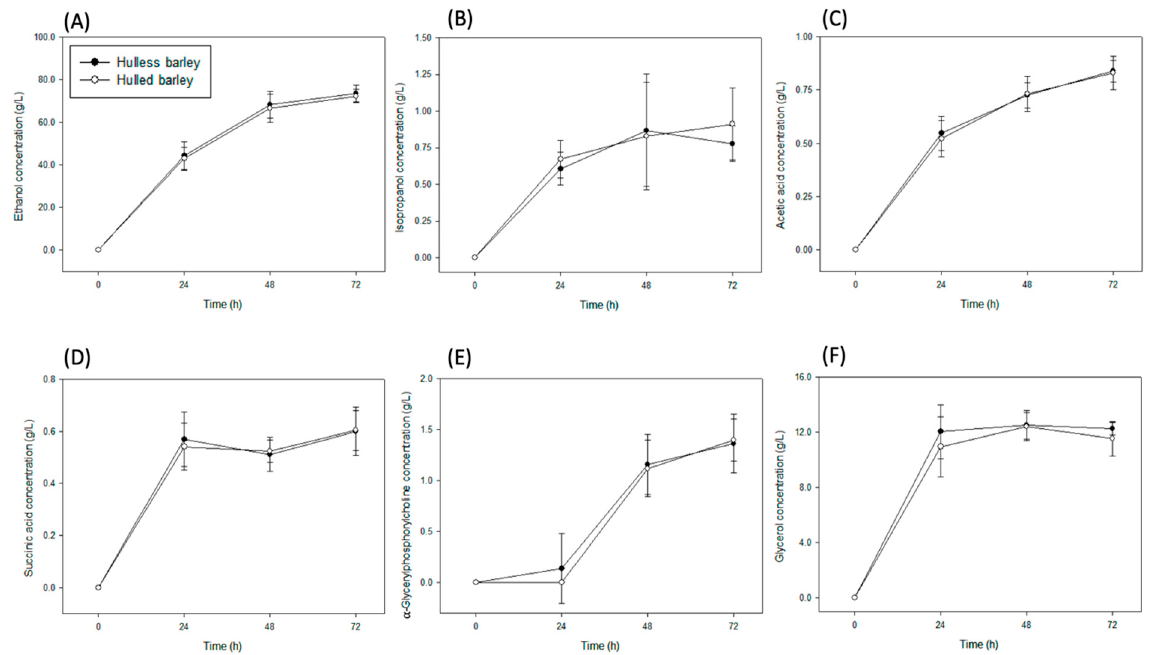
Figure 6. Average fermentation product yields for ethanol ( A ), isopropanol ( B ), acetic acid ( C ), succinic acid ( D ), ⍺ -glycerylphosphorylcholine ( E ), and glycerol ( F ) for barley with and without hulls.